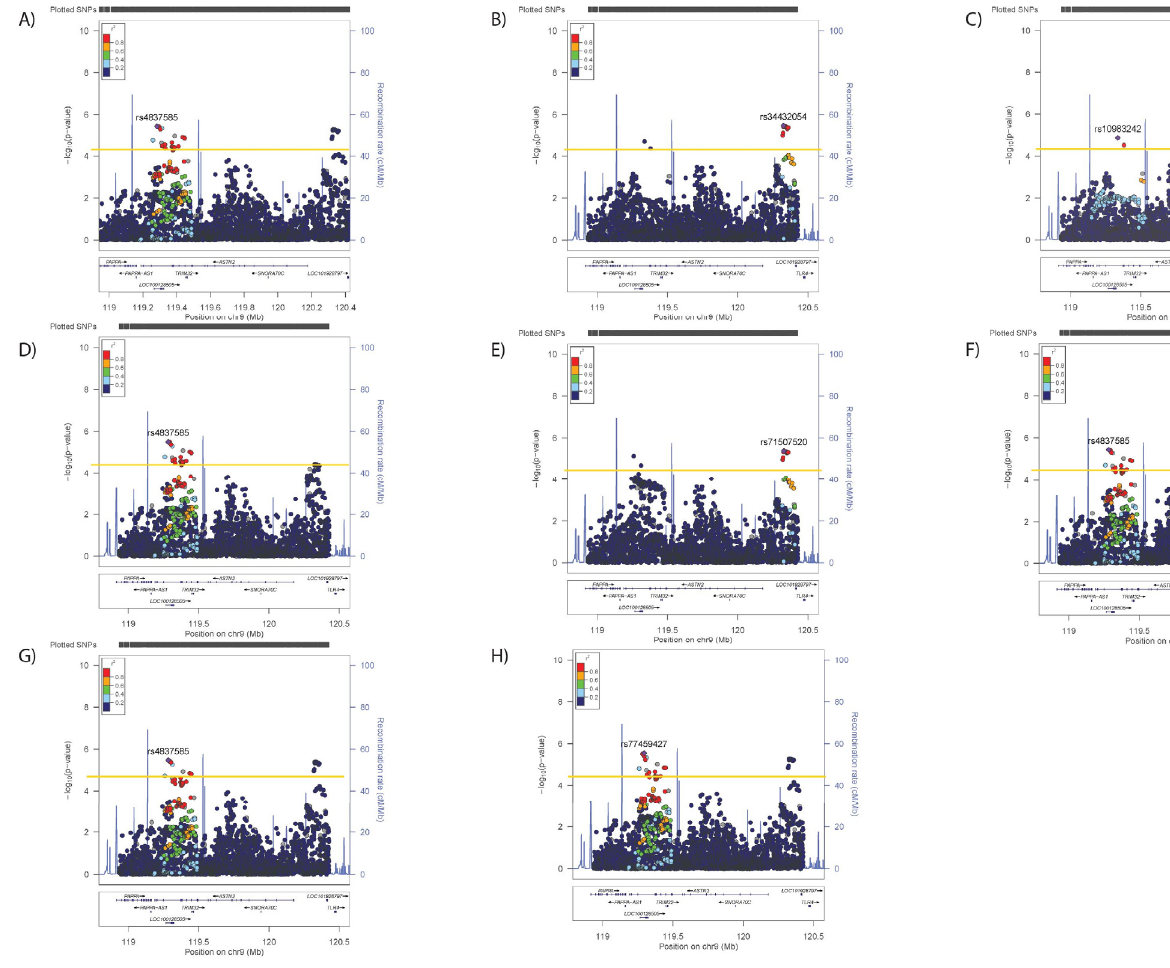
Figure 3. Results of associations between ASTN2 and ( A ) DBP, adjusted for the primary SNP for ( B ) SBP/DBP, ( C ) primary and secondary SNPs for DBP, ( D ) primary SNP for BMI, ( E ) WHRadjBMI, ( F ) neuroticism, ( G ) anhedonia and ( H ) mood instability. Significance was set at p -value < 5.45 × 10 − 5 or − log10 > 4.26 (Horizontal yellow line). LD (r2) with the lead SNP are indicated by colour. Grey indicates that there is no LD information available.